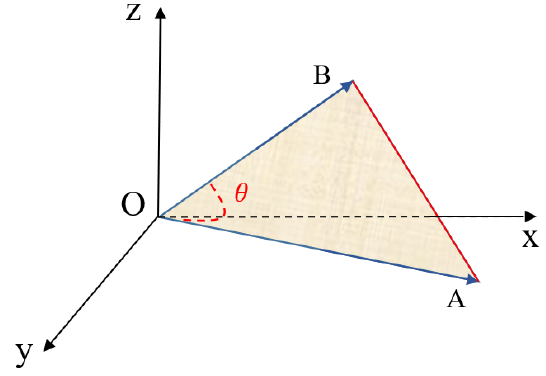
→ → OA and OB in three-dimensional